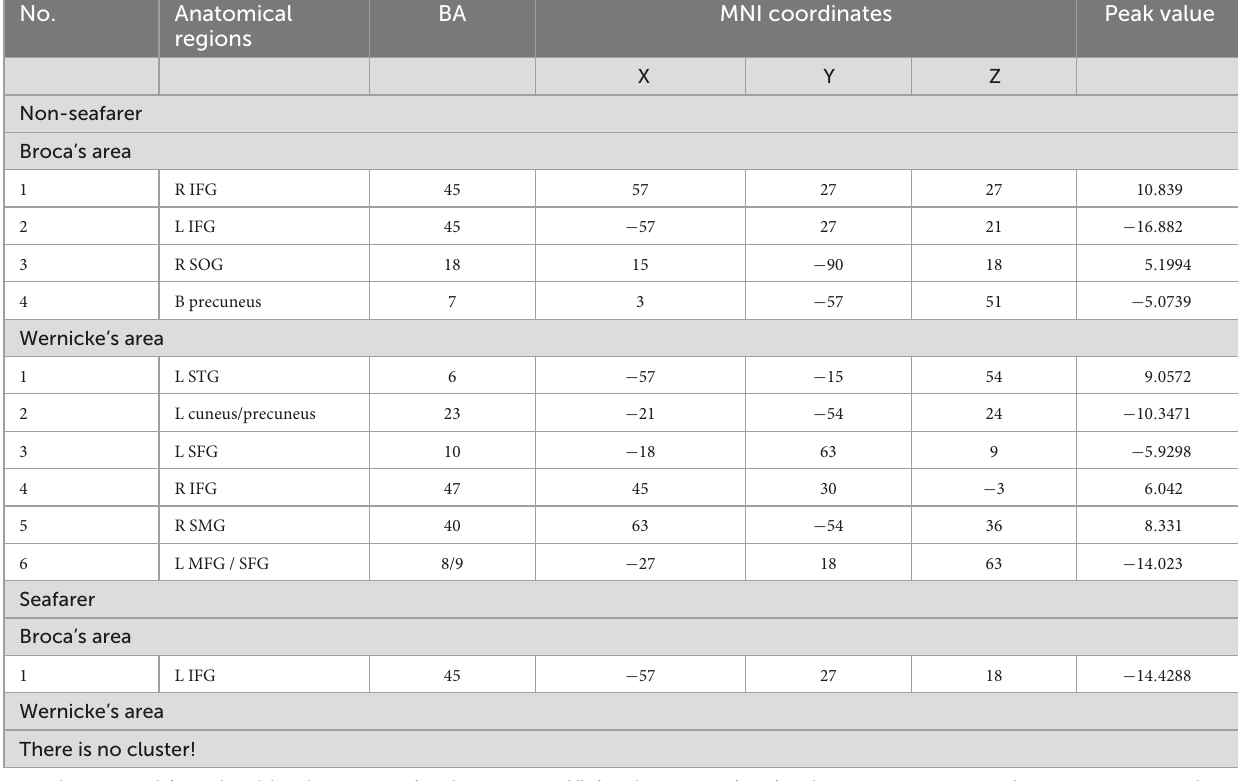
TABLE 2 The cerebral regions involving significant functional lateralization with Broca’s and Wernicke’s areas in the seafarer group and non-seafarer group ( p 0.005, cluster size > 200 voxels, corresponding to corrected p FWE 0.05). No.